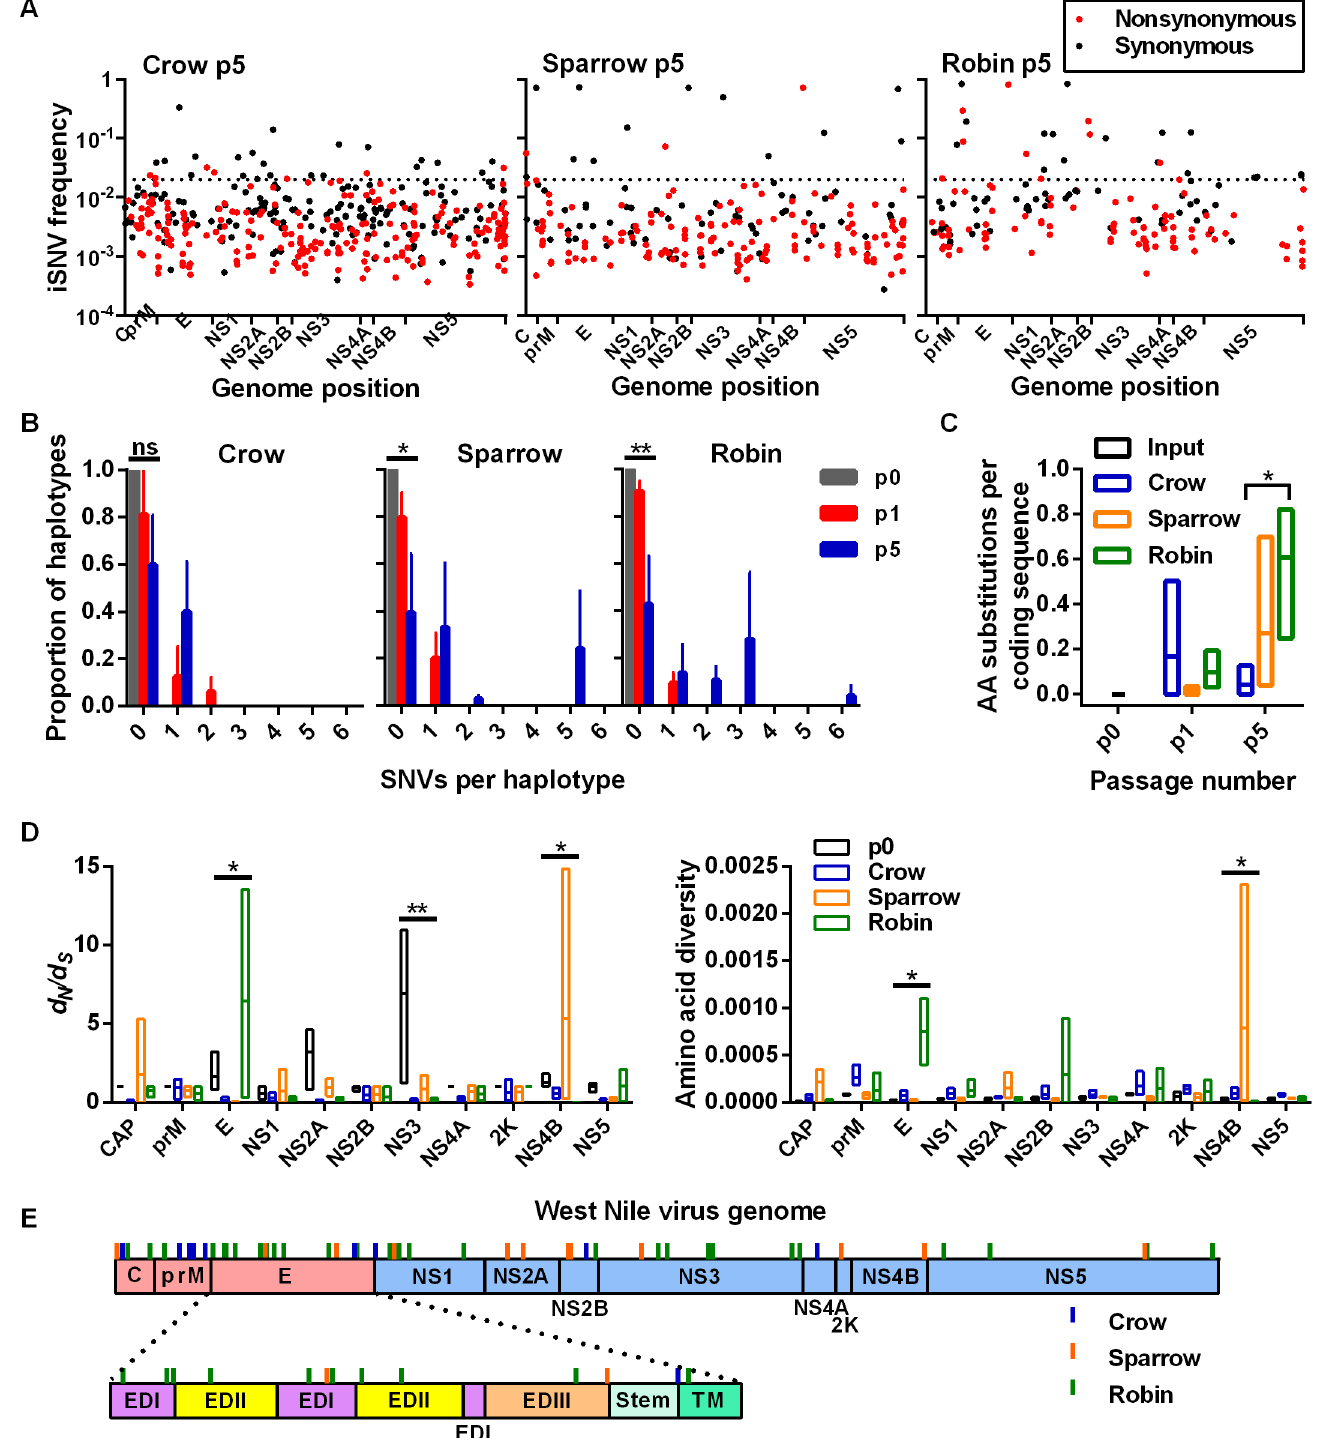
Fig 4. High-frequency iSNVs contribute to haplotype displacement in a bird-species dependent manner. ( A ) iSNVs from input virus (p0) and after passage 5 (p5, all replicates combined) plotted according to genome position. Red and black dots represent synonymous and nonsynonymous iSNVs, respectively. Dotted line represents division between high and low frequency iSNVs (0.02). ( B ) Haplotypes were reconstructed from high frequency iSNVs represented by the number of SNVs per haplotype (i.e. Hamming distance from the p0 haplotype, ± SEM) (ns, not significant; * , P = 0.0250; ** , P = 0.0036, Kruskal-Wallis test). ( C ) Mean ( ± range) number of amino acid (AA) substitutions per coding sequence from high frequency iSNVs at p5 in each bird species